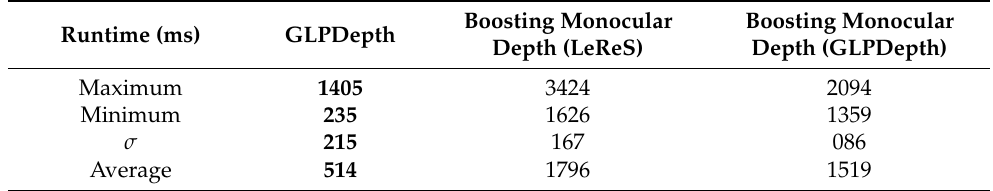
Table 10. Inference runtime comparison on Gascola trajectory; the values in bold are the best results using Boosting Monocular Depth with LeReS and